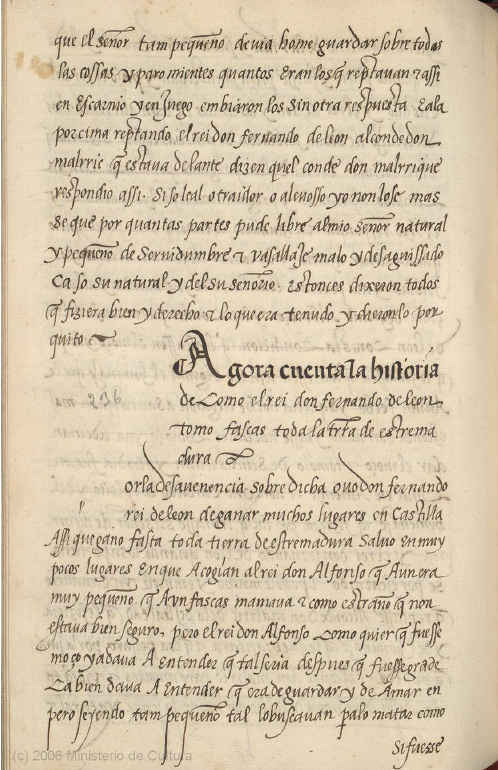
Figure 1. Sample image of a Spanish document from the 16th